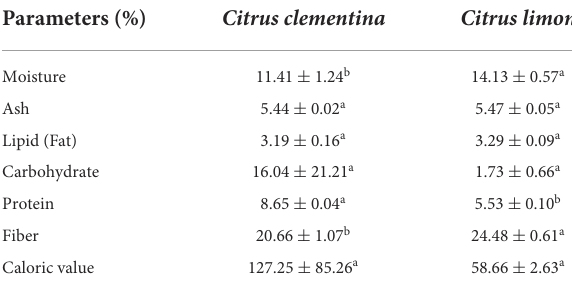
TABLE 1 Proximate composition (%) of whole Citrus clementina and Citrus limon